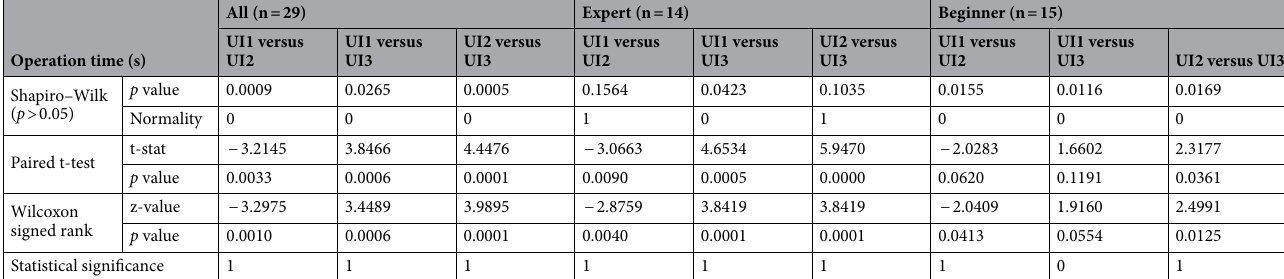
Table 2. Statistical analyses for operation time.